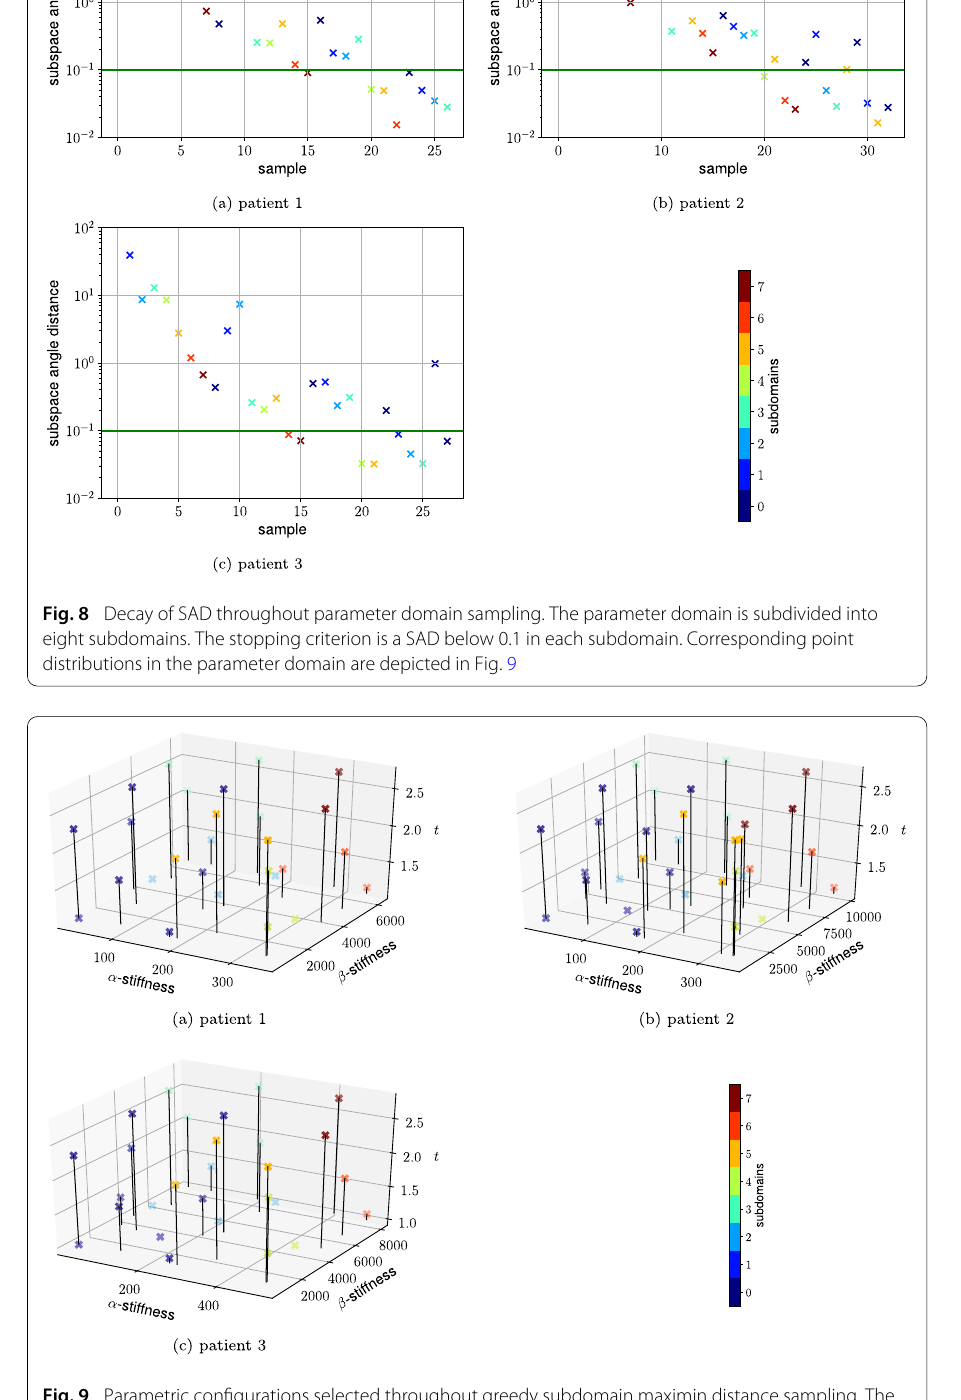
Fig. 9 Parametric configurations selected throughout greedy subdomain maximin distance sampling. The parameter domain is subdivided into eight